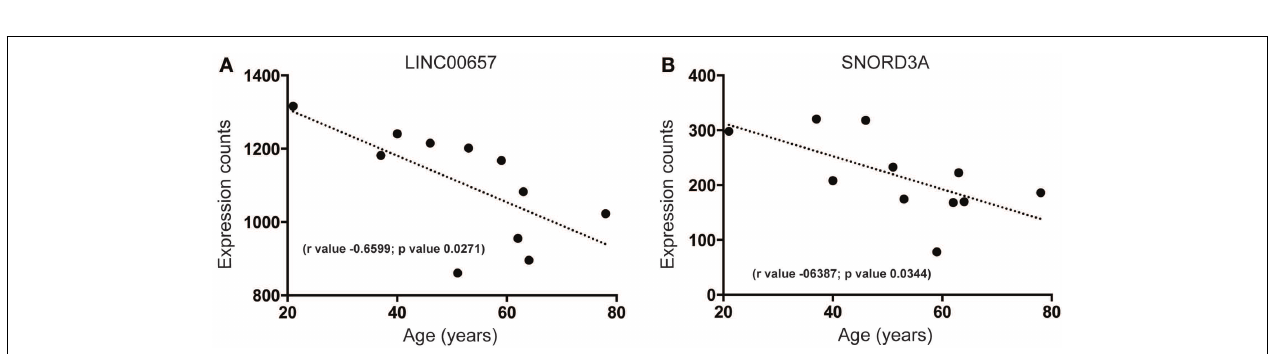
the lncRNAs (A) LINC00657 (Validated by quantitative PCR; Figure S2C in Supplementary Material) and (B) SNORD3A. (Significance is defined as p value <